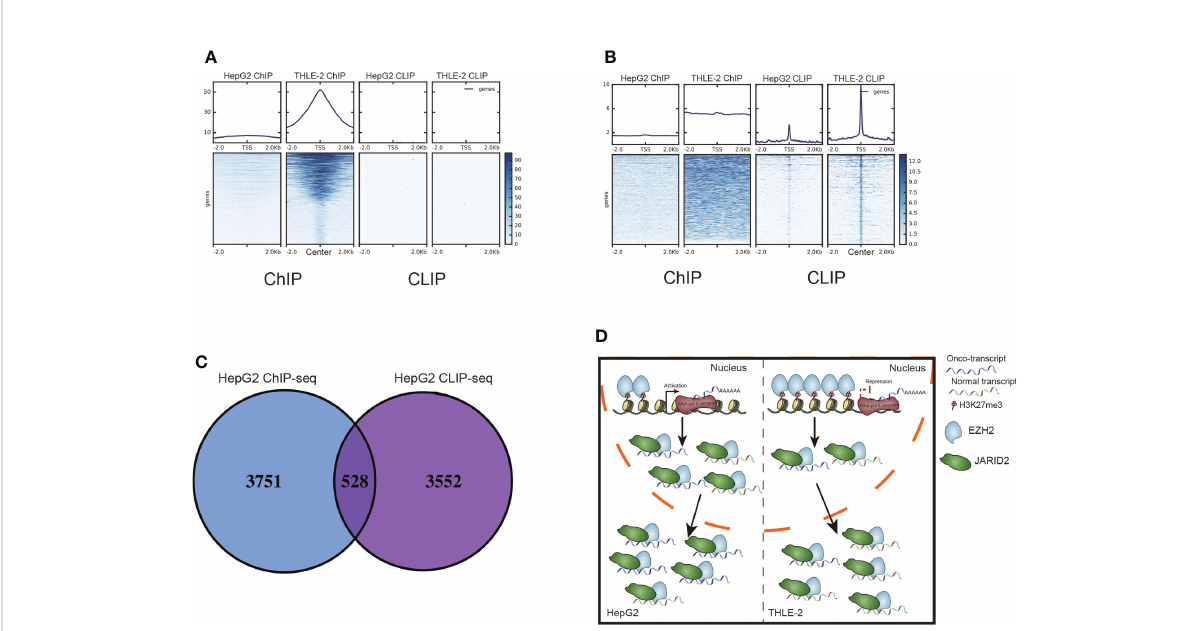
FIGURE 5 The interaction between bound RNAs and DNAs by EZH2 and JARID2. (A) Heatmap presentation for the reads density of ChIP-seq and CLIP- seq samples around the center of peaks from THLE-2 EZH2 DNA binding pro fi le (ChIP-seq). (B) Heatmap presentation for the reads density of ChIP-seq and CLIP-seq samples around the center of peaks from THLE-2 EZH2 RNA binding pro fi le (CLIP-seq). (C) Venn diagram showing the bound genes by EZH2 ChIP-seq and CLIP-seq samples from HepG2 cells. (D) Working model of EZH2 and JARID2 in HCC. In HepG2 cells, EZH2 exhibits weak DNA binding, thus activating more onco-expression and then binding more to highly expressed RNAs together with JARID2 to produce a more mature onco-transcript. In THLE-2 cells, the DNA binding ability of EZH2 is maintained and represses the expression of oncogenes, and then reduced binding with RNA to produce a less mature